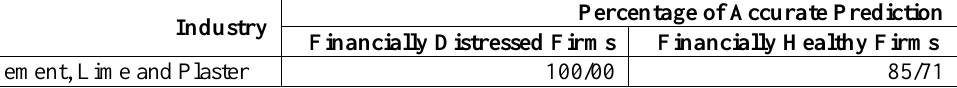
Table (16). Accuracy of Final Model for Predicting Corporate Default in the Group of Financially Distressed and Healthy